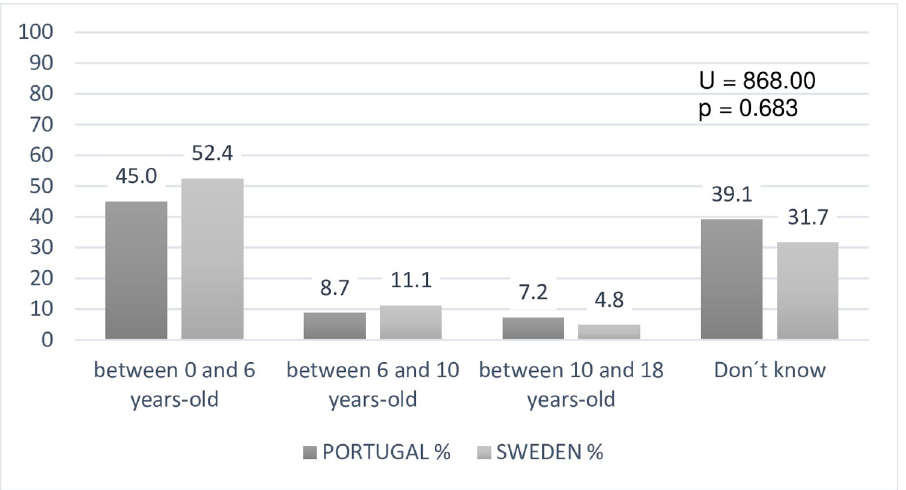
Fig 4. Teachers’ perceptions about increased visual skills manifestation ages (N =